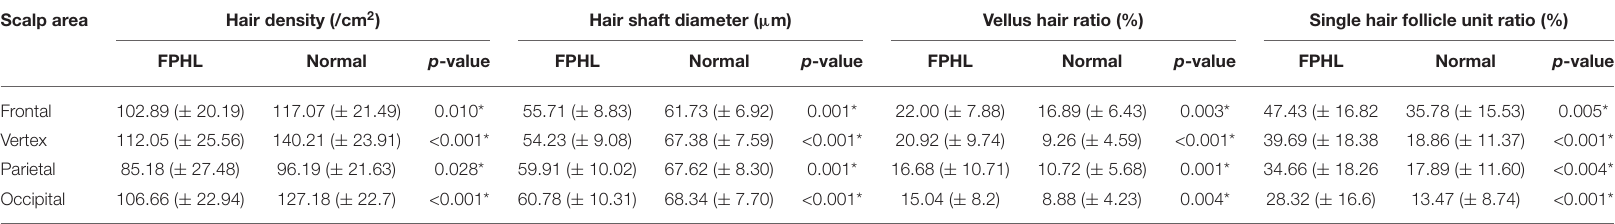
TABLE 2 | Hair parameters of FPHL patients and normal subjects.